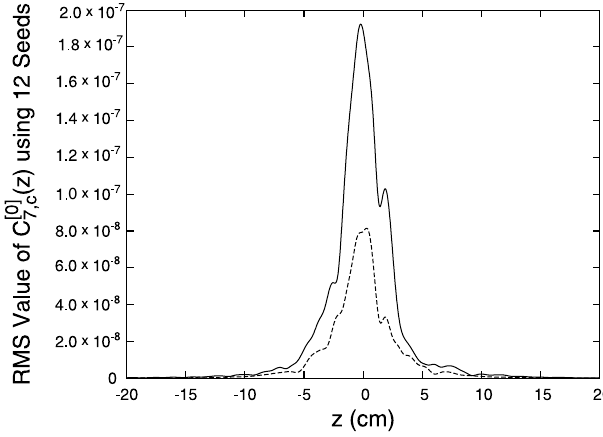
ð k Þ = Se 0 ð U; q Þ for the case m ¼ 1 FIG. 18. The kernels k m (cid:7) r m r and r ¼ 1 ; 3 ; 5 ; 7 ; 9 ; 11 , as a function of k , with q and k related by